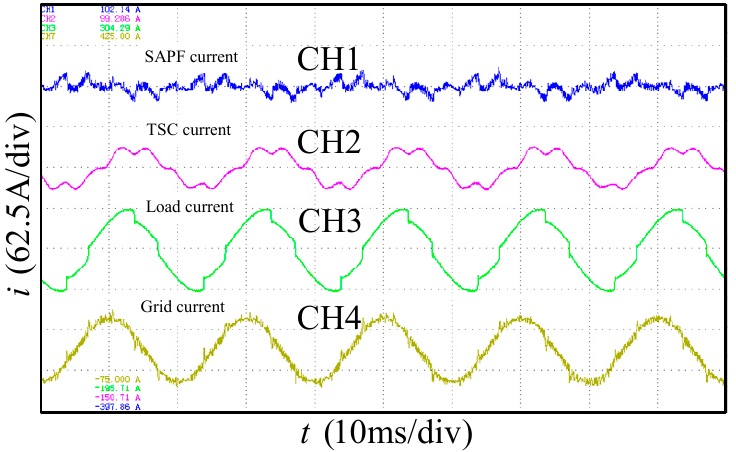
Figure 21. Experimental waveforms of hybrid system (CH1—SAPF current; CH2—TSC current; CH3—load current; CH4—grid current).